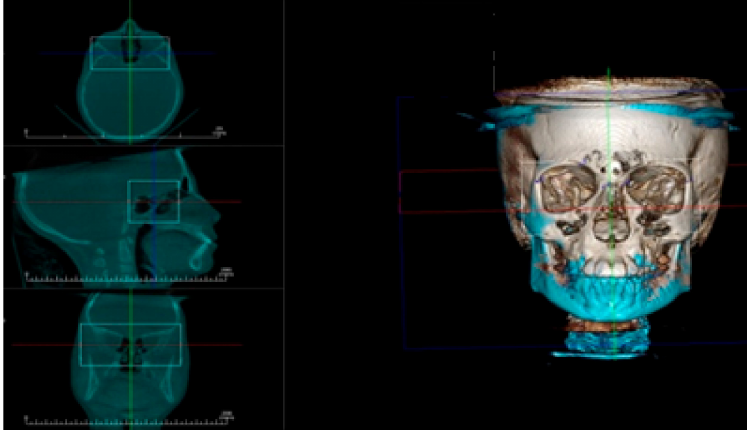
Figure 4. Automatic volume-based registration for superimposition of T1 and T2 CBCT images utilized in the study. Orthogonal planes: axial, coronal, and sagittal aligned as reference planes for analysis of condylar head position, Vertical Plane (VP, blue line), Frankfort Horizontal Plane (FHP, red line) and midsagittal plane (MSP, green